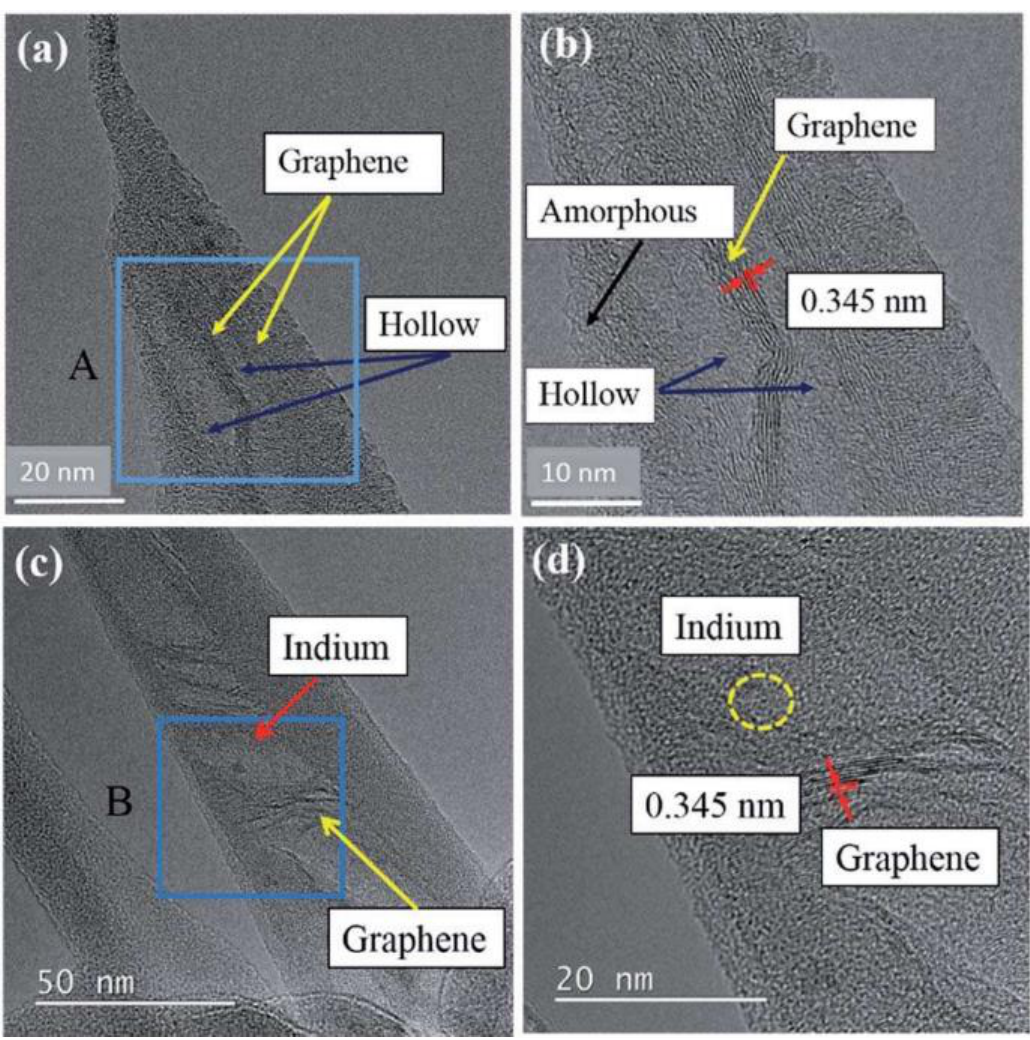
Figure 6. ( a – d ) Typical TEMs of graphene nano flakes in different forms, synthesized by an indium catalyst at 150 °C. Reproduced from [72] (CC BY).